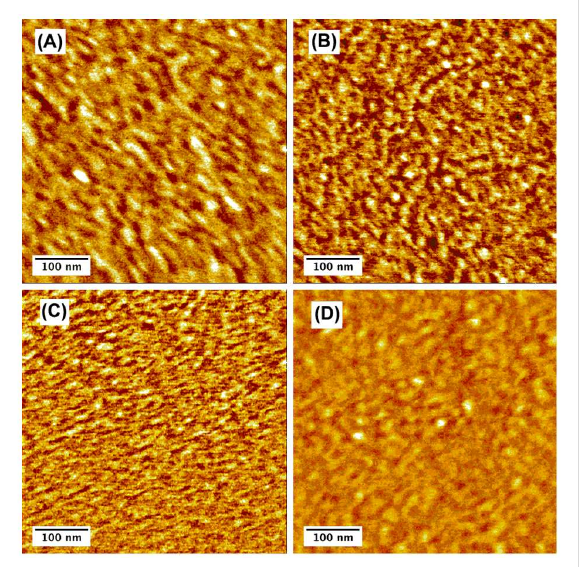
Figure 2: AFM phase images of P3HT/fullerene blend films containing (A) PCBM, (B) ThCBM, (C) 2-BThCBM ( 3a ), and (D) es-TThCBM ( 3d ) for a 500 × 500-nm 2 area.